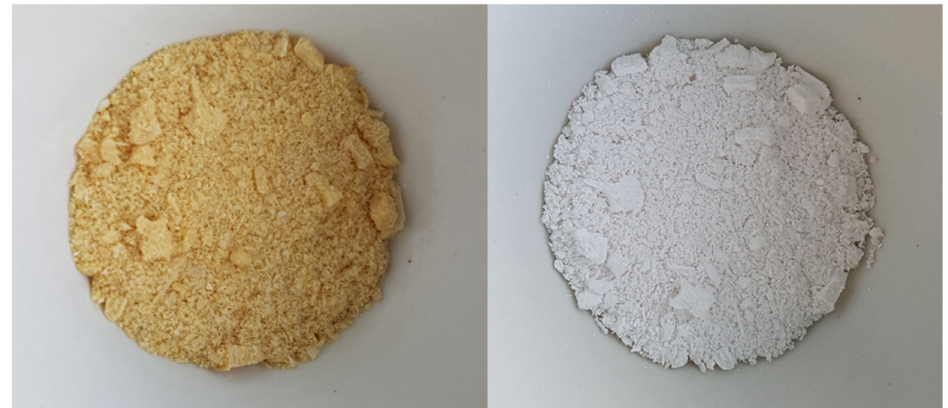
Figure 2. Crushed fish bones before and after thermal treatment.